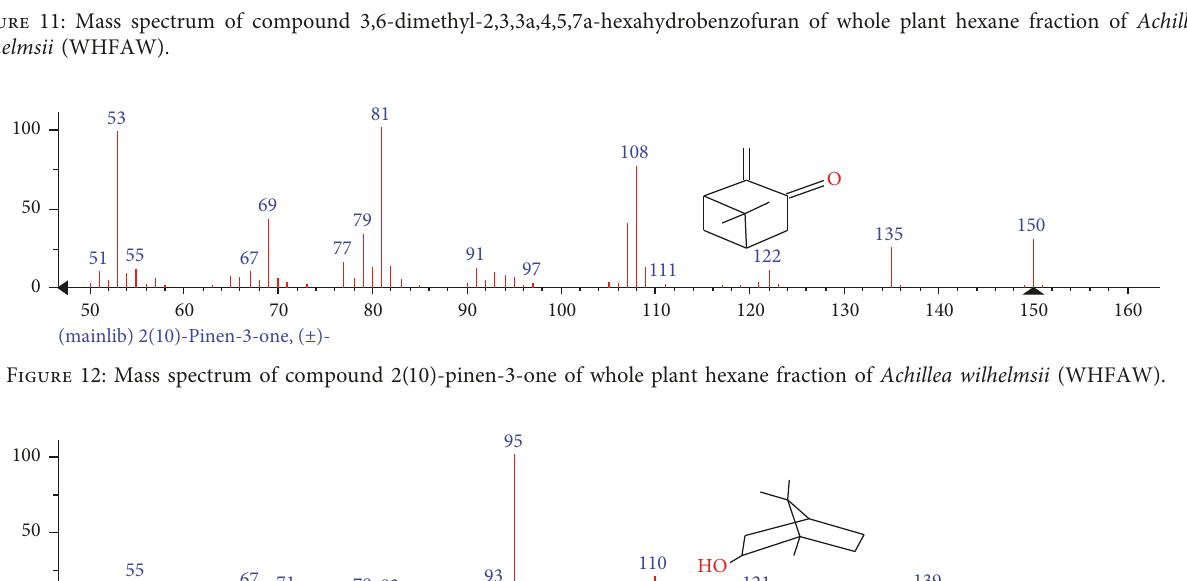
(1S-endo)-50 60 (replib) Bicyclo[2.2.1]heptan-2-ol, 1,7,7-trimethyl-, Figure 13: Mass spectrum of compound bicyclo[2.2.1]heptan-2-ol, 1,7,7-trimethyl-, (1S-endo)- of whole plant hexane fraction of Achillea wilhelmsii (WHFAW).